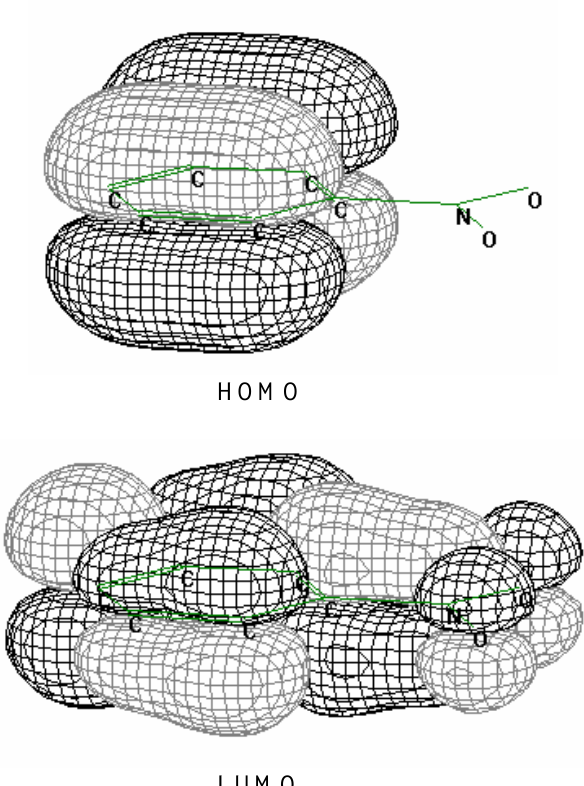
Figure 2. Frontier orbitals of